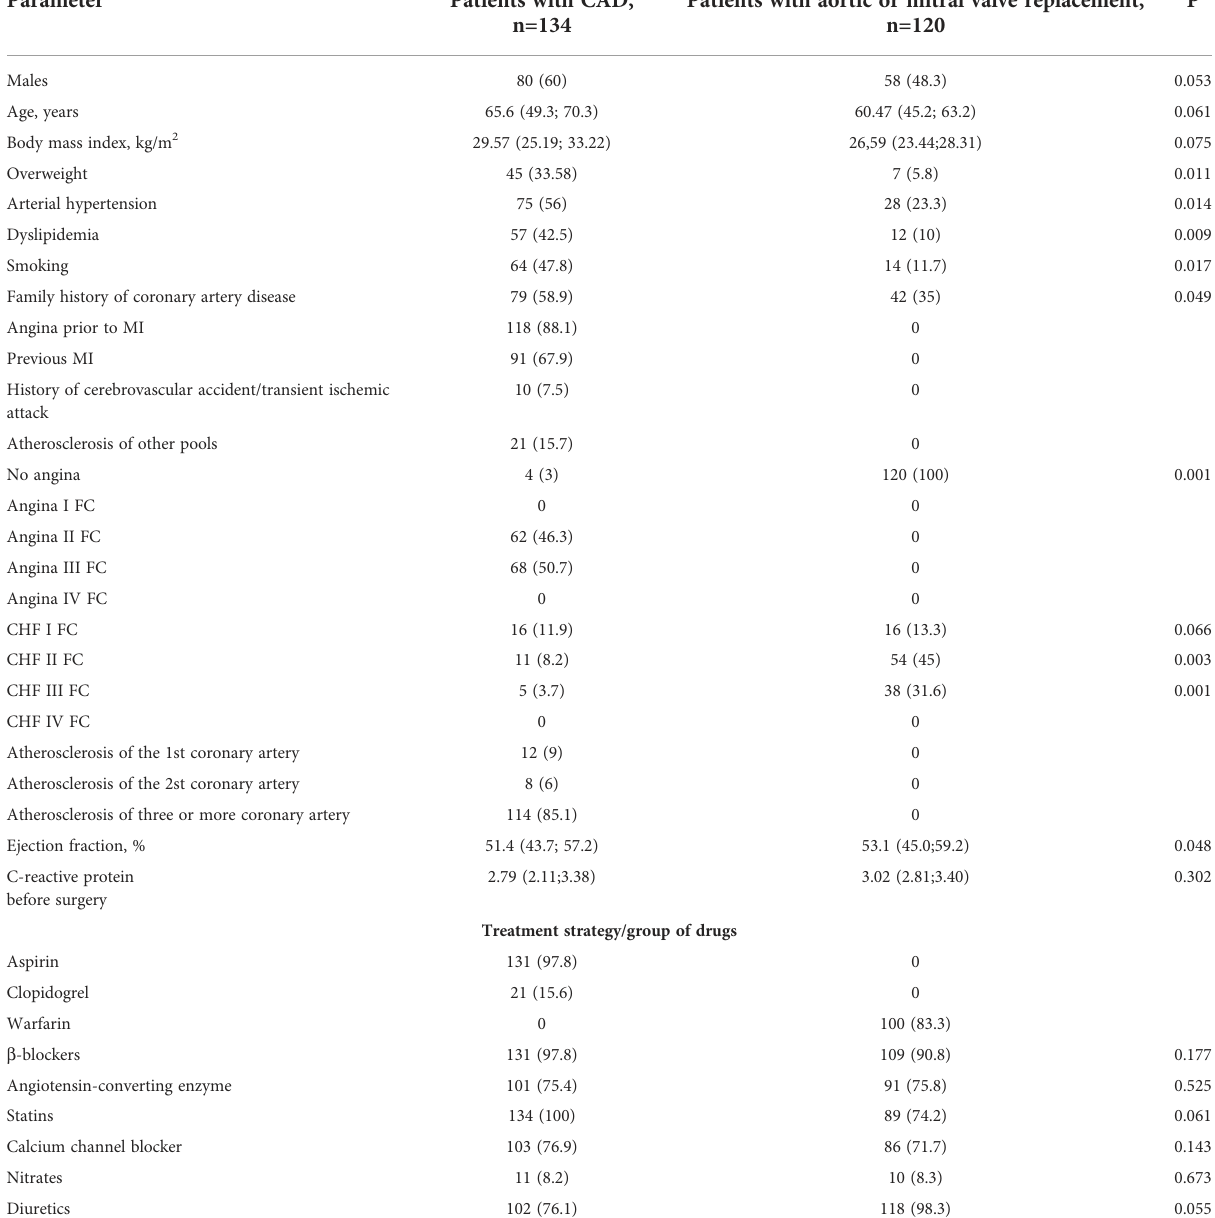
TABLE 1 Clinical and medical history of patients with coronary heart disease. Parameter Patients with CAD,